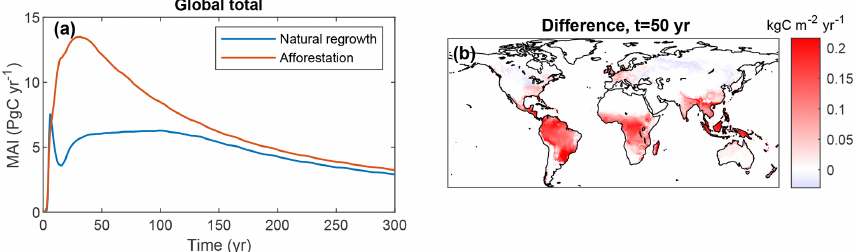
Figure 8. Mean ecosystem sequestration rate (mean annual increment, MAI), determined as total C storage divided by time since the start of LPJmL simulations with only forest plantations or only natural vegetation. (a) Global total versus time; (b) difference between (afforestation minus natural regrowth) after 50 years.